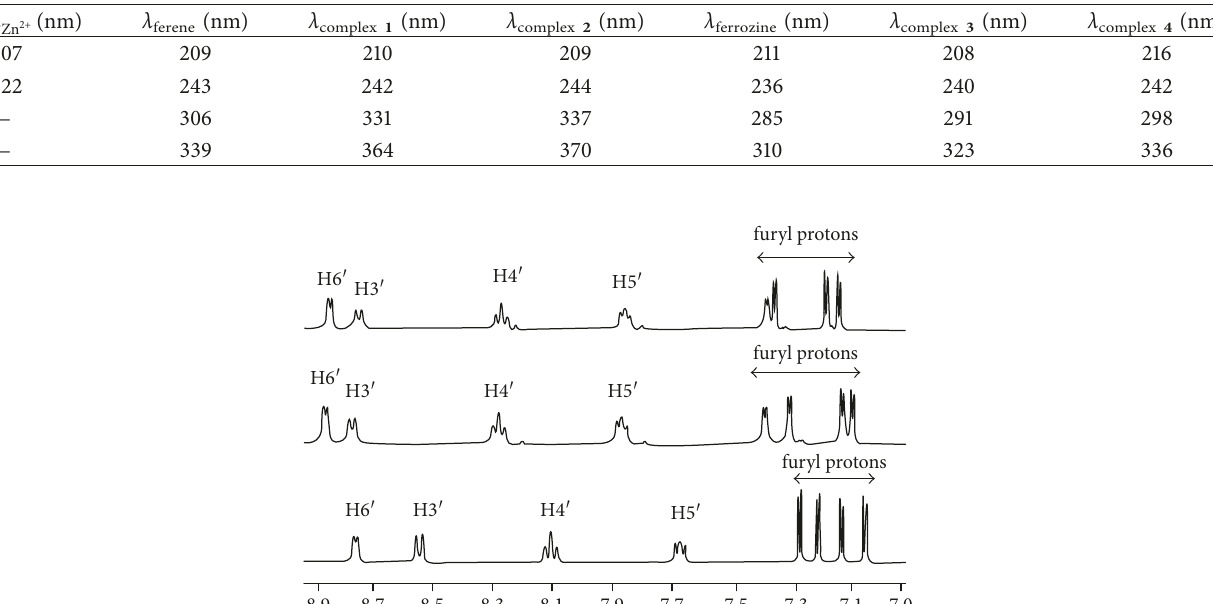
Table 1: Comparison of UV-Vis data of ferene, ferrozine, and complexes 1–4 .